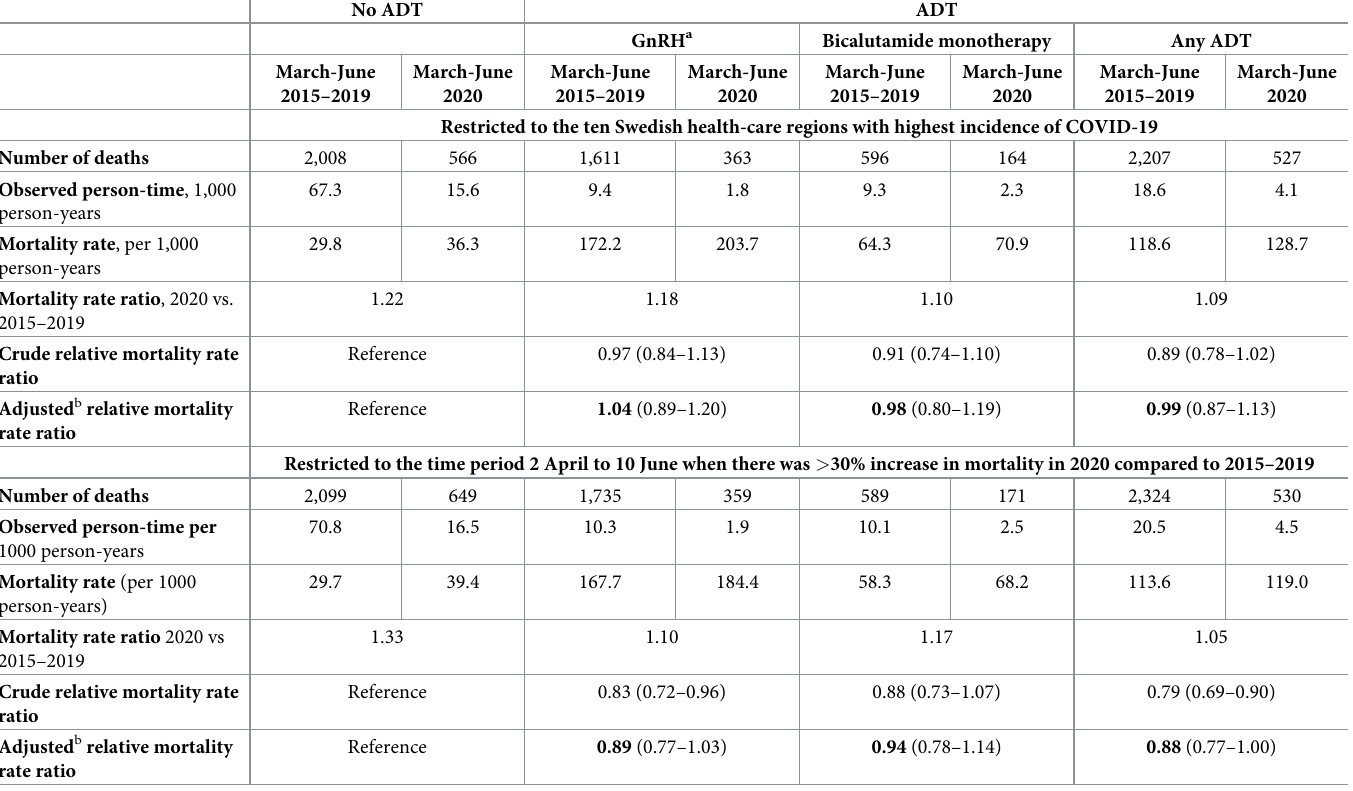
Table 3. Association between exposure to GnRH agonists, bicalutamide monotherapy, or any androgen deprivation therapy (ADT) and all-cause mortality in men with prostate cancer in PCBaSe. No ADT